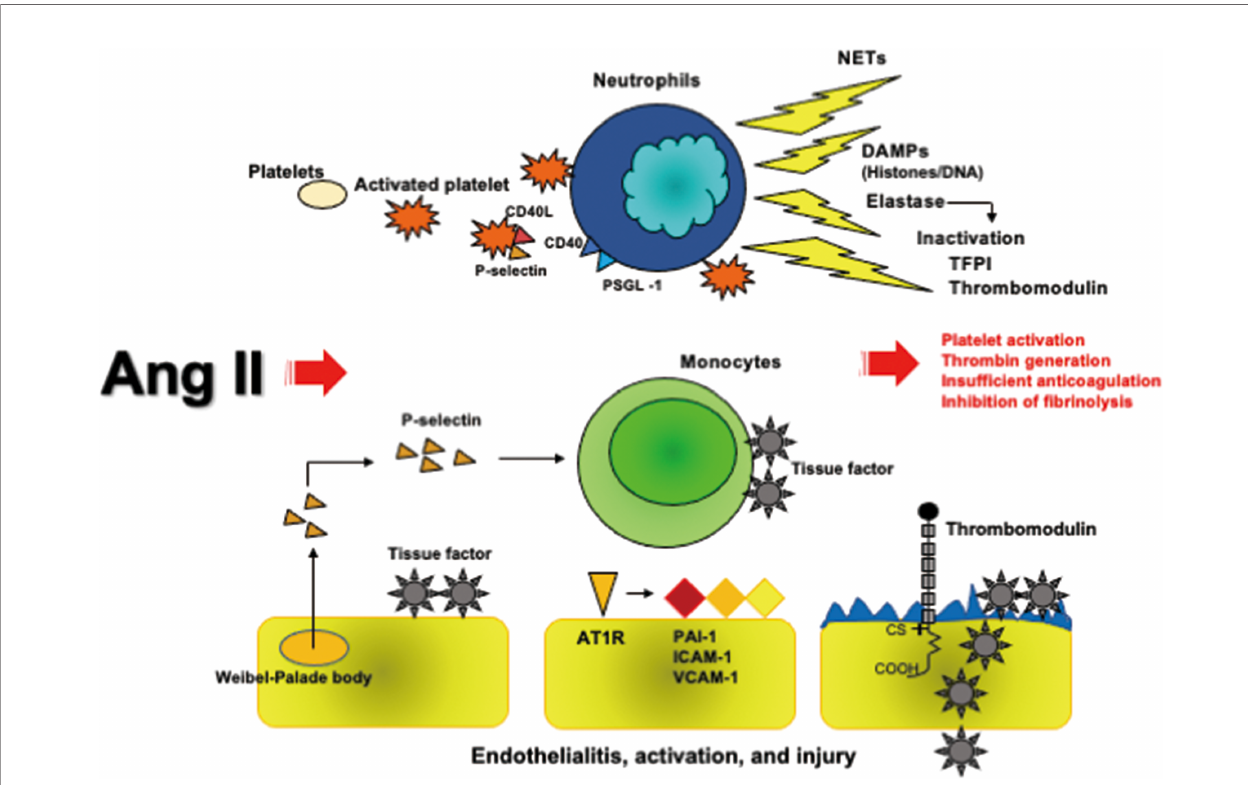
FIGURE 2 | Ang II-induced coagulopathy. Ang II activates platelets expressing P-selectin and CD40L, consequently binding with CD40 and PSGL-1 expressed on neutrophils followed by NETs formation, which contain neutrophil DNA and histones decorated with elastase. Histones have a potent prothrombotic property and elastase cleaves to inactivate TFPI and thrombomodulin. Ang II and P-selectins express tissue factor on monocytes and endothelial cells. Ang II further induces the expressions of PAI-1, ICAM-1, and VCAM-1 on endothelial cells via AT1R. SARS-CoV-2-developed endothelialitis may reduce thrombomodulin expression like herpes simplex virus infection. All these processes caused by Ang II induce thrombus formation. Ang II, angiotensin II; AT1R, angiotensin II type 1 receptor; DAMPs, damage-associated molecular patterns; ICAM-1, intercellular adhesion molecule-1; NETs, neutrophil extracellular traps; PAI-1, plasminogen activator inhibitor; PSGL- 1, P-selectin glycoprotein ligand-1; SARS-CoV-2, severe acute respiratory syndrome coronavirus 2; TFPI, tissue factor pathway inhibitor; VCAM-1, vascular cell adhesion